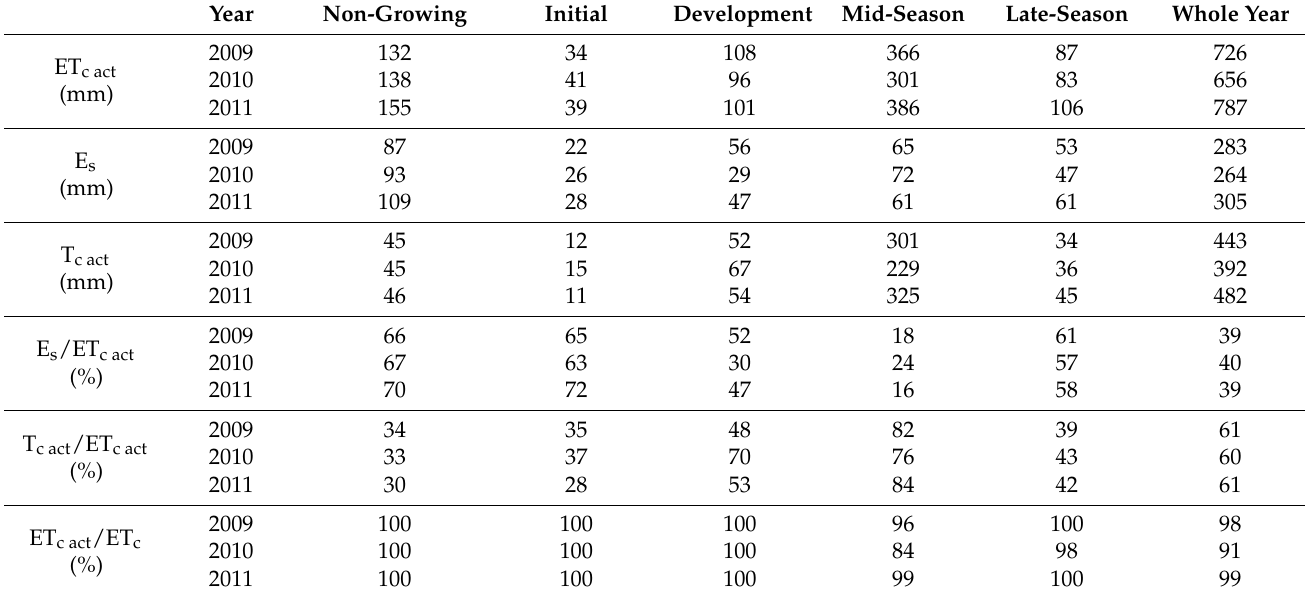
Table 6. Olives’ actual evapotranspiration (ET c act ) and its partitioning into soil evaporation (E s ) and actual transpiration (T c act ), and ratios between soil evaporation and actual evapotranspiration (E s /ET c act , %) between actual crop transpiration and actual evapotranspiration (T c act /ET c act , %) and between actual evapotranspiration and potential evapotranspiration (ET c act /ET c, %) throughout the diverse crop stages and years.